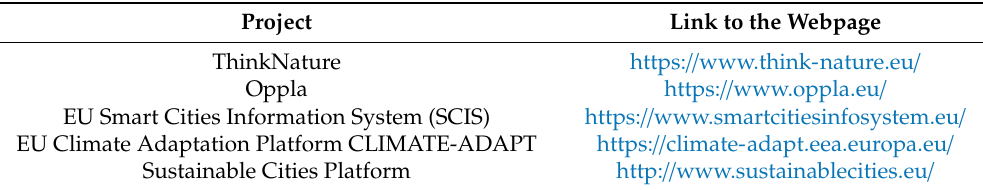
Table 4. EU dialogue platforms for the promotion of